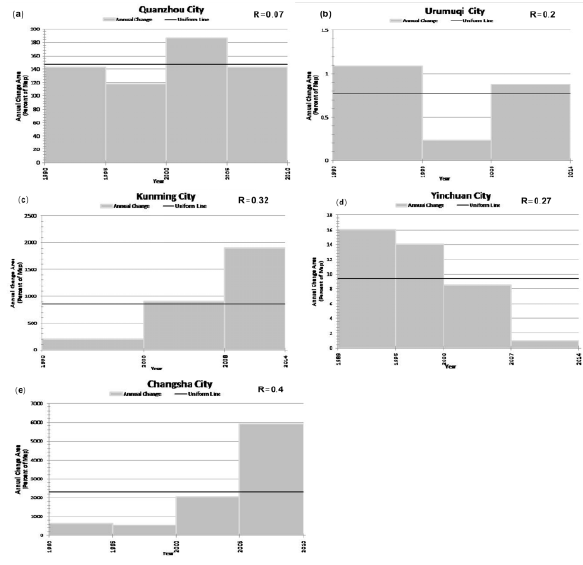
Figure 5. Land use instability: (a) The most stable cities, (b) The mid-ranked instability, (c) - （ e ） The most